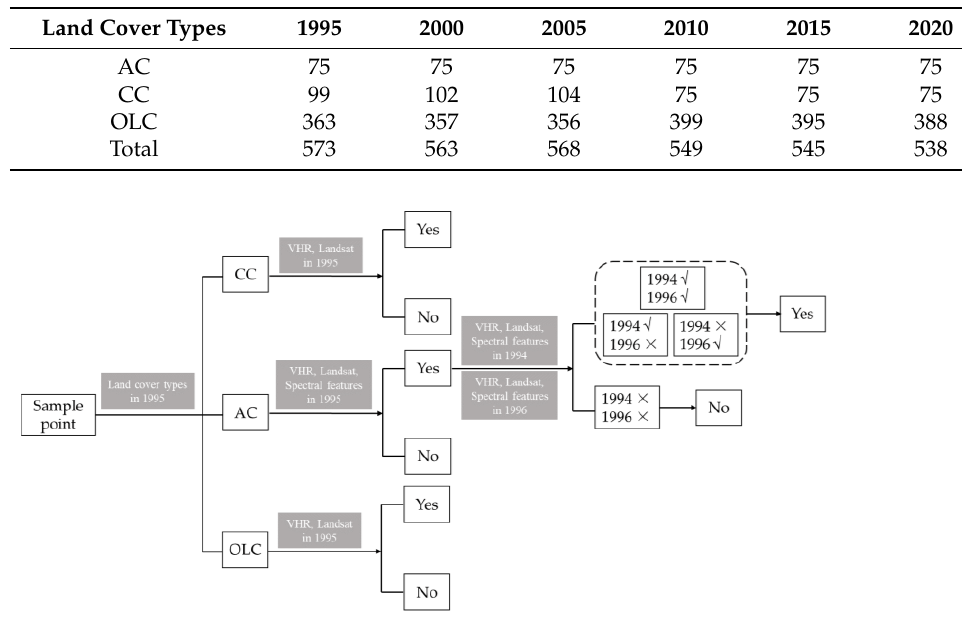
Figure 11. Example of verification process for annual cropland abandonment map in 1995.